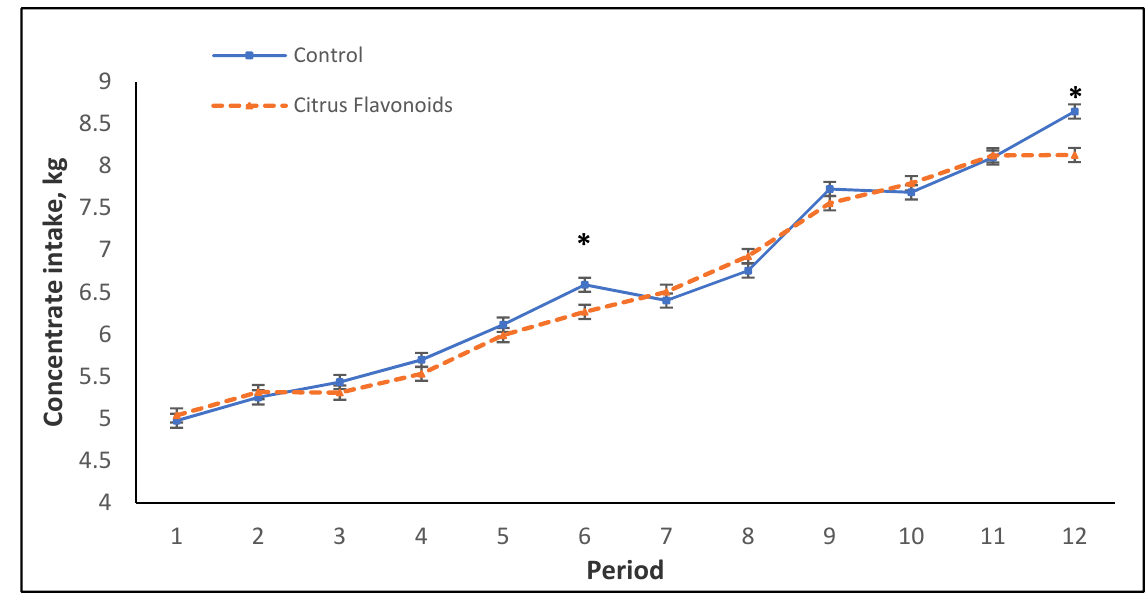
44.555.566.5 Figure 1. Mean of the concentrate intake during the growing and finishing phases of Holstein bulls fed high-concentrate diets with or without citrus flavonoids supplementation (* = p < 0.05).